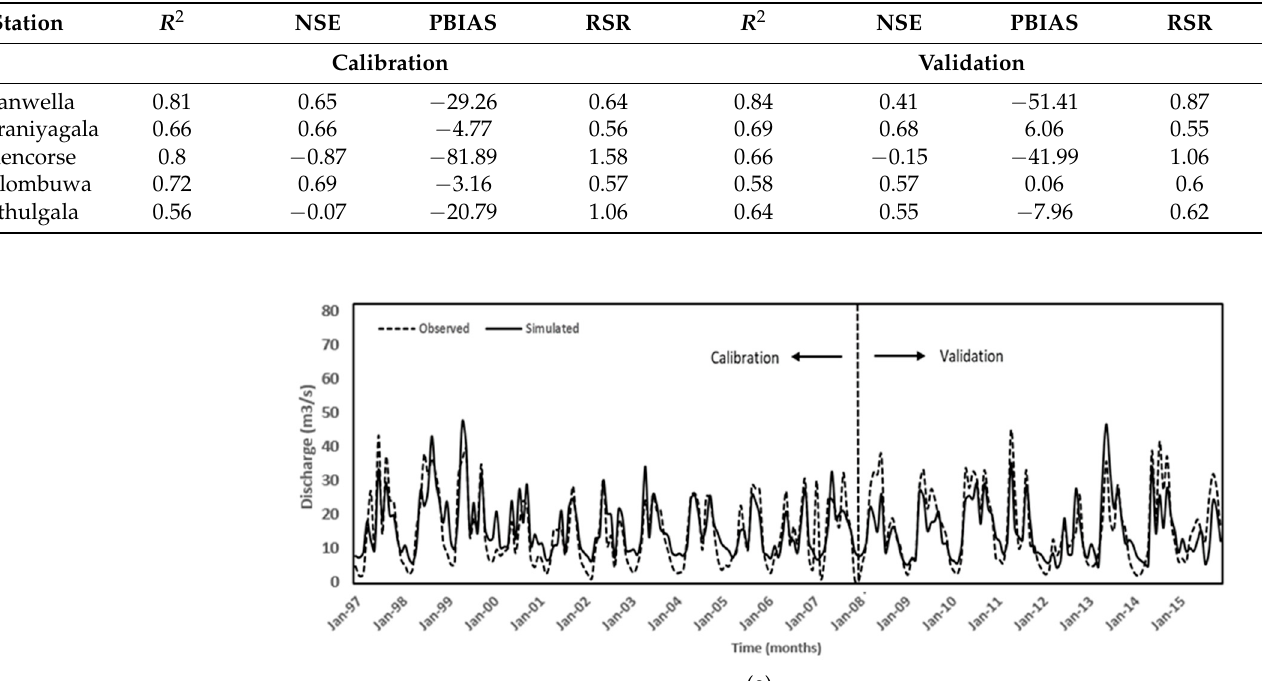
Table 6. Performance evaluations for the monthly discharge simulation (Deraniyagala sub-basin).